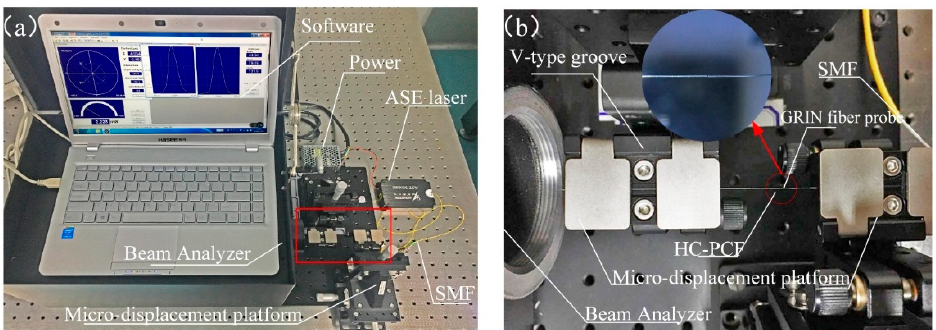
Figure 3. Schematic of the experimental system.